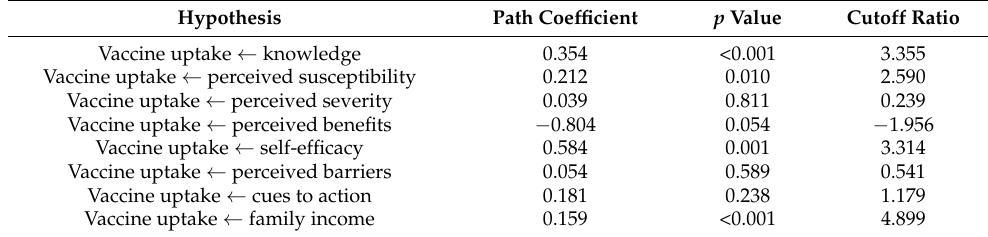
Table 6. Path coefficient in the structural equation